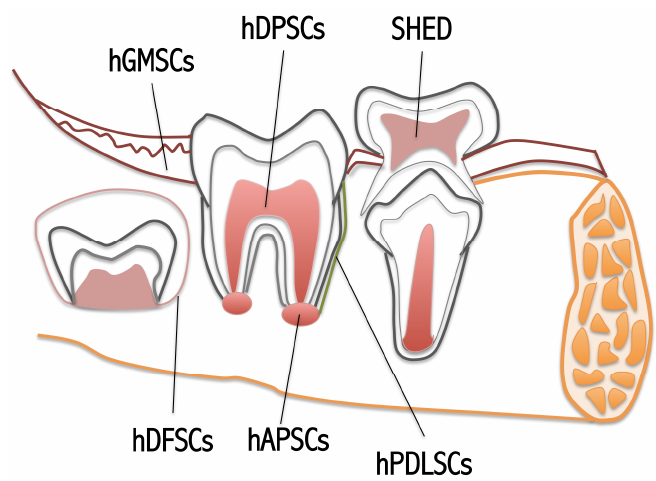
Figure 2. Schematic view of the orally derived MSCs .